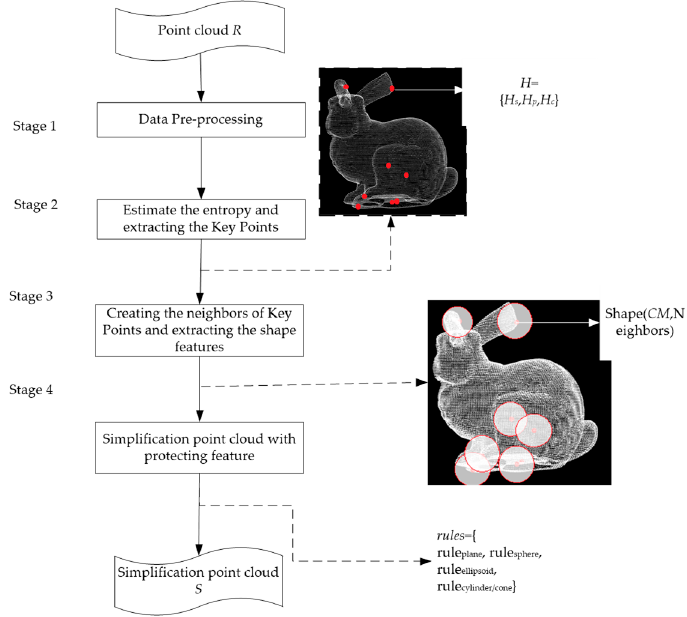
Figure 1. The proposed framework for FPPS (feature-preserved point cloud simplification).